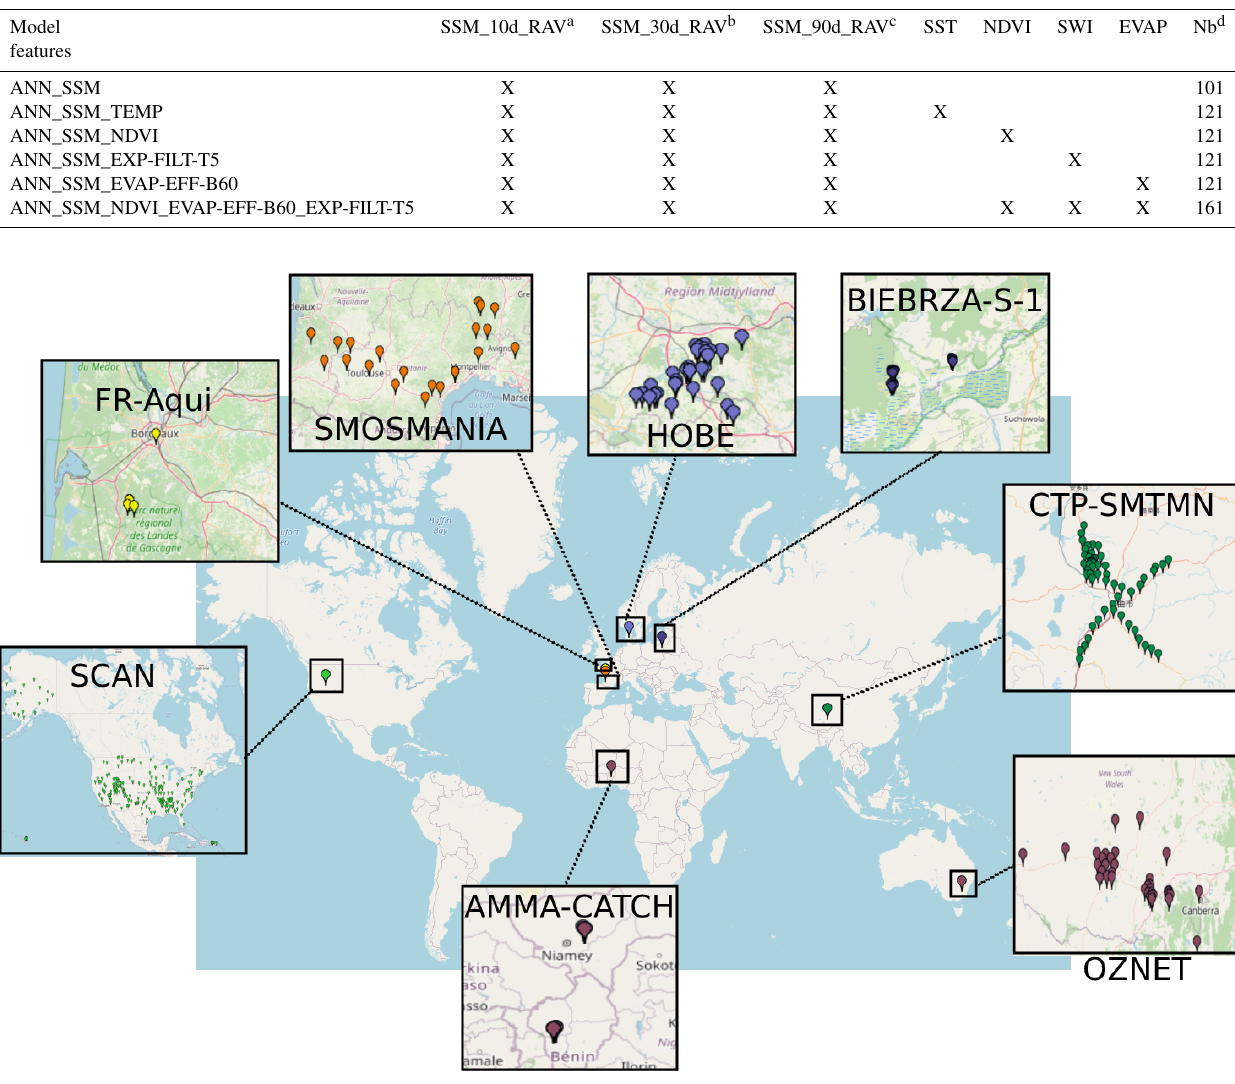
Table 1. ANN model configurations with the respective input variables; a : rolling averages of SSM over 10d; b : rolling averages of SSM over 30d; c : rolling averages of SSM over 90d; d : number of parameters of the ANN model.